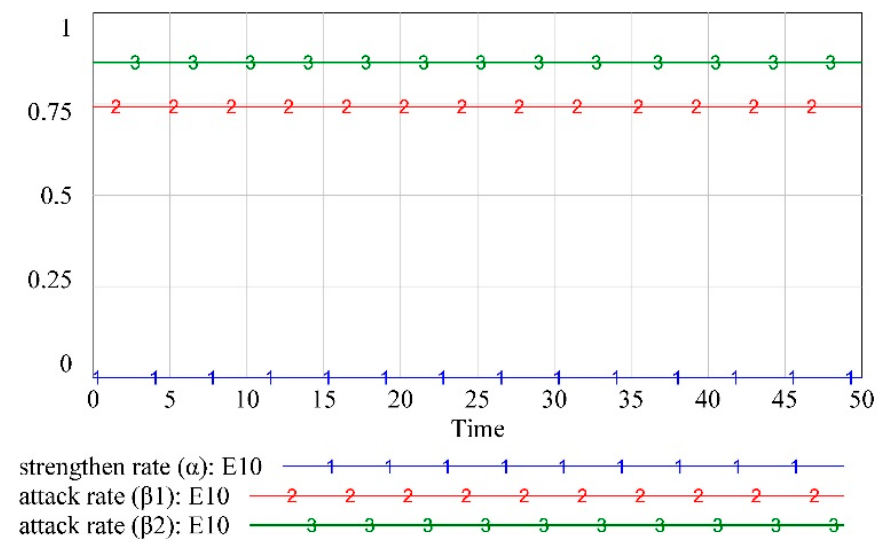
Figure 4. Game results under initial strategy E 10 .